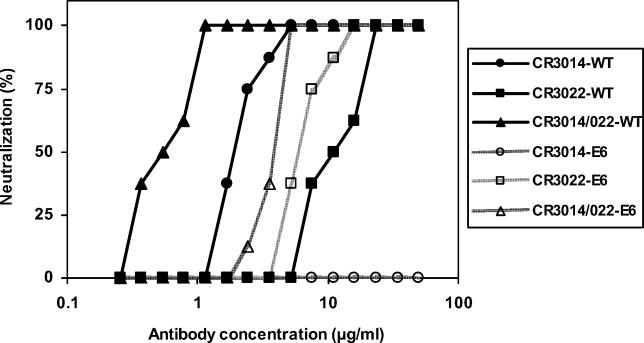
Neutralization of Wild-Type SARS-CoV and a CR3014-Neutralization Escape Variant (E6) with mAbs CR3014 and CR3022 Individually and in CombinationNeutralization of 100 TCID
50 of each virus was performed in octuplicate. Data are also shown in
Table 1.